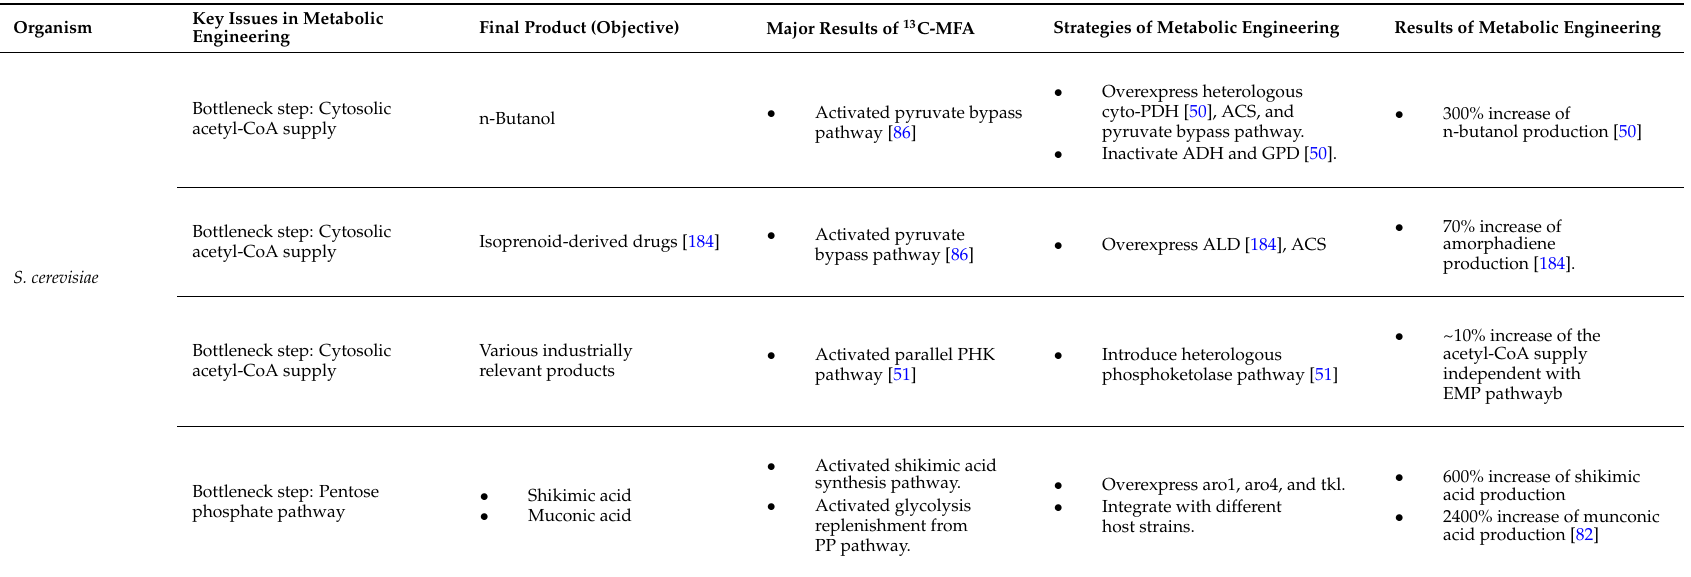
Table 2. Summary of synergistic tactics of 13 C-MFA and metabolic engineering a